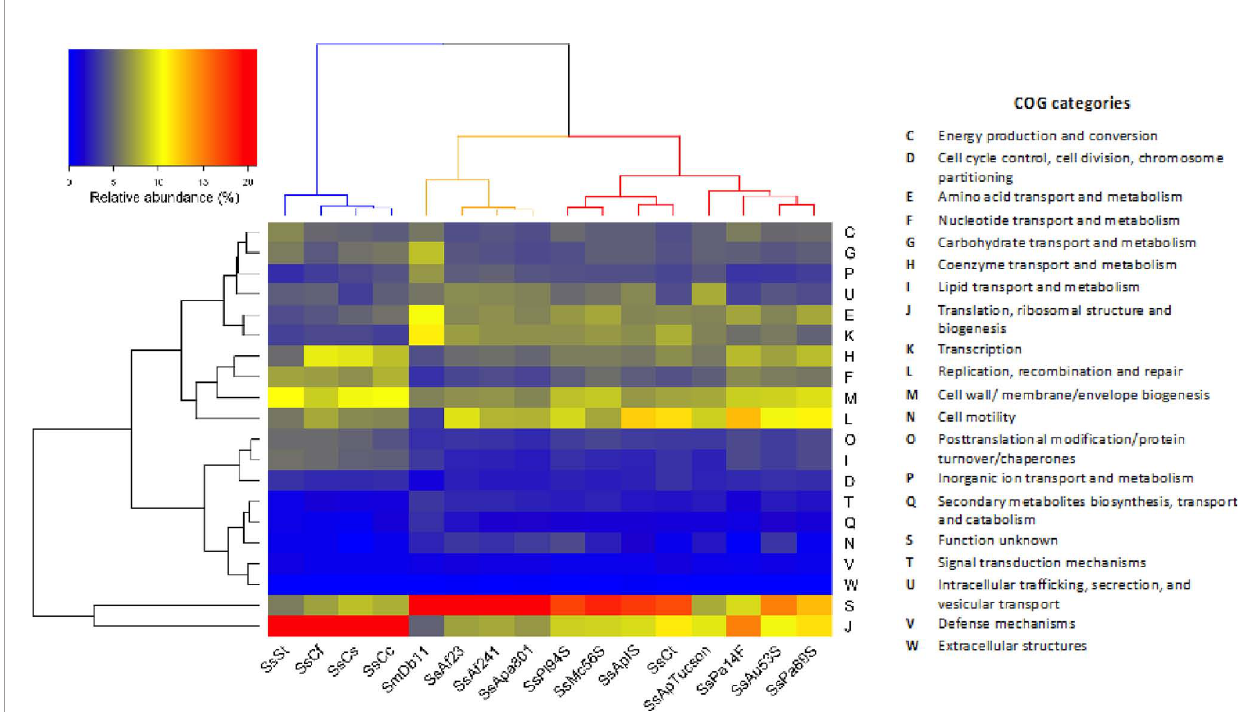
FIGURE 2 | Functional pro fi les of selected S. symbiotica strains and S. marcescens Db11. Two-way hierarchical clustering heatmap showing the relative abundance of CDSs in each COG categories according to the total number of CDSs in each genome. Cladogram at the top highlights three main clusters among S. symbiotica strains: one cluster including only S. symbiotica from Clade B (left cluster); one cluster grouping all culturable strains with S. marcescens Db11 (middle cluster); and one cluster including facultative and co-obligate S. symbiotica strains (right